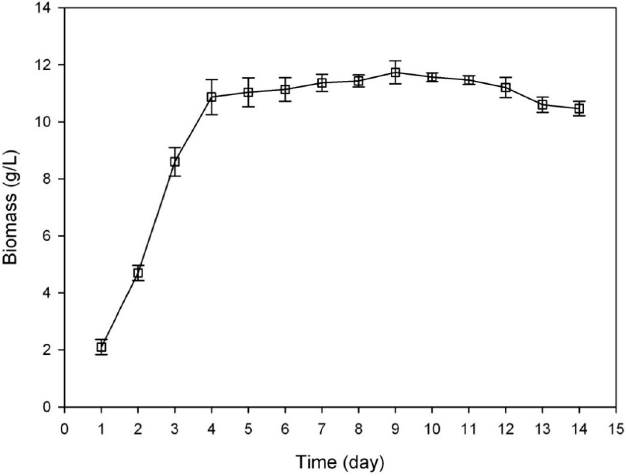
Figure 1. The growth curve of C. sinensis grown on basal medium (BM). The error bars indicate standard deviations of the dry